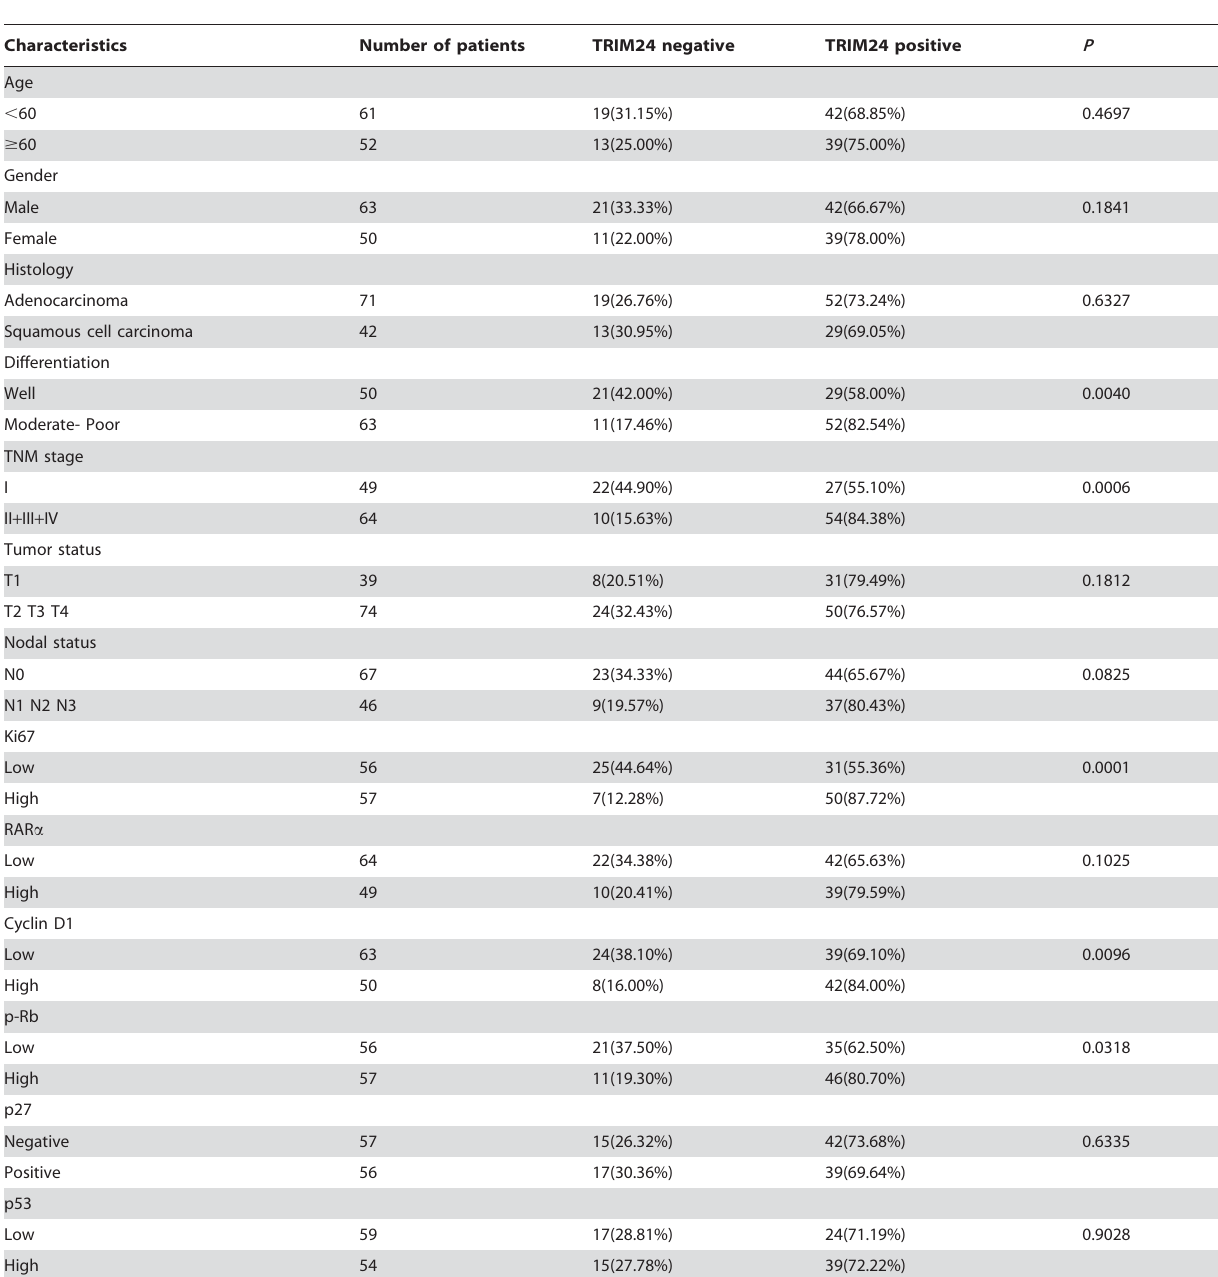
Table 1. Distribution of TRIM24 status in NSCLC according to clinicopathological characteristics.